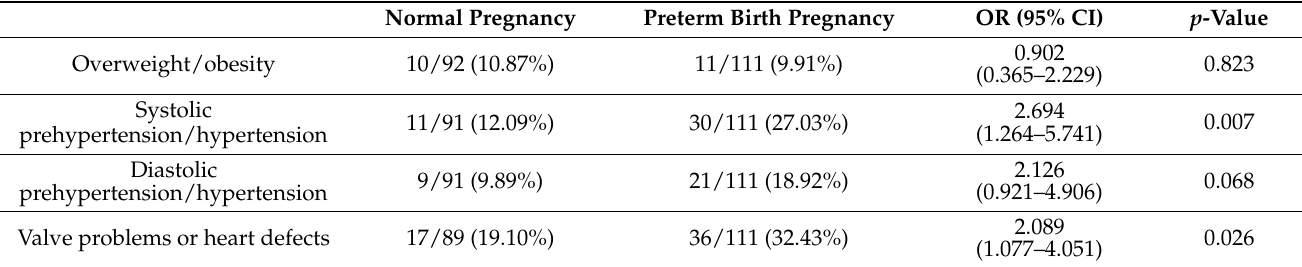
Table 2. Clinical outcomes of preterm- and term-born